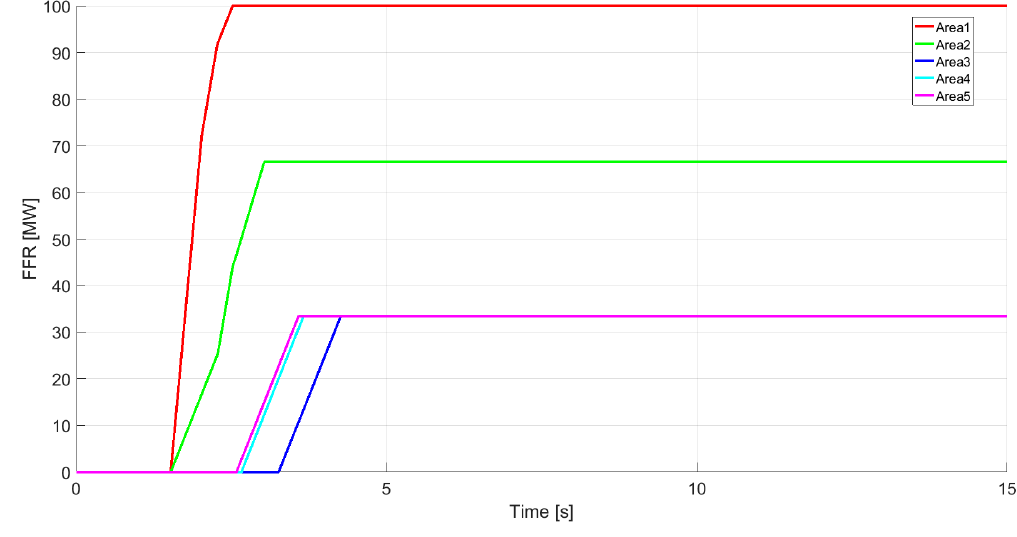
Figure 23. FFR in different areas.